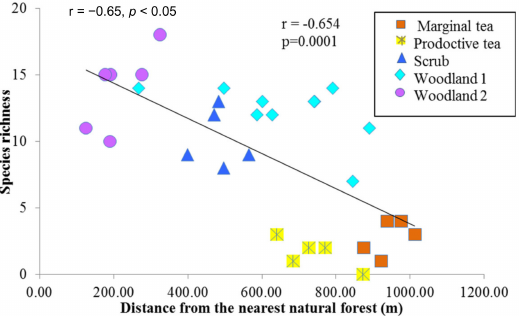
Figure 3. A scatterplot between the species richness and distance from the Sinharaja Rainforest Complex. Species richness was measured within 20 m × 20 m plots including all trees >1 cm DBH within the Endane Biodiversity Corridor, Dilmah Conservation and Kahawatte Plantations PLC., located close to the Sinharaja Rainforest Complex in the Rathnapura District of Sri